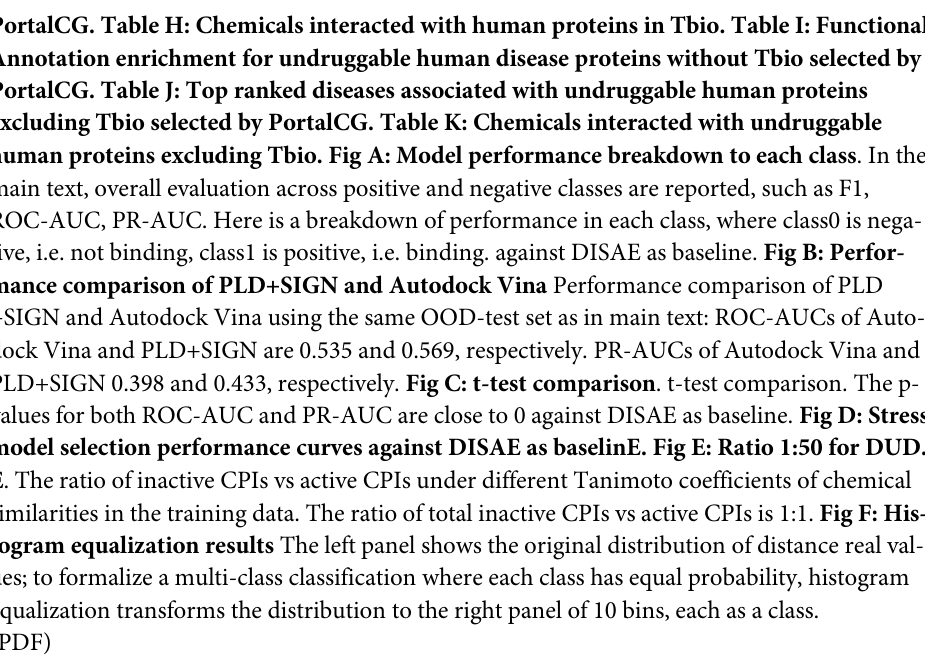
PortalCG. Table H: Chemicals interacted with human proteins in Tbio. Table I: Functional Annotation enrichment for undruggable human disease proteins without Tbio selected by PortalCG. Table J: Top ranked diseases associated with undruggable human proteins excluding Tbio selected by PortalCG. Table K: Chemicals interacted with undruggable human proteins excluding Tbio. Fig A: Model performance breakdown to each class . In the main text, overall evaluation across positive and negative classes are reported, such as F1, ROC-AUC, PR-AUC. Here is a breakdown of performance in each class, where class0 is nega- tive, i.e. not binding, class1 is positive, i.e. binding. against DISAE as baseline. Fig B: Perfor- mance comparison of PLD+SIGN and Autodock Vina Performance comparison of PLD +SIGN and Autodock Vina using the same OOD-test set as in main text: ROC-AUCs of Auto- dock Vina and PLD+SIGN are 0.535 and 0.569, respectively. PR-AUCs of Autodock Vina and PLD+SIGN 0.398 and 0.433, respectively. Fig C: t-test comparison . t-test comparison. The p- values for both ROC-AUC and PR-AUC are close to 0 against DISAE as baseline. Fig D: Stress model selection performance curves against DISAE as baselinE. Fig E: Ratio 1:50 for DUD. E . The ratio of inactive CPIs vs active CPIs under different Tanimoto coefficients of chemical similarities in the training data. The ratio of total inactive CPIs vs active CPIs is 1:1. Fig F: His- togram equalization results The left panel shows the original distribution of distance real val- ues; to formalize a multi-class classification where each class has equal probability, histogram equalization transforms the distribution to the right panel of 10 bins, each as a class.